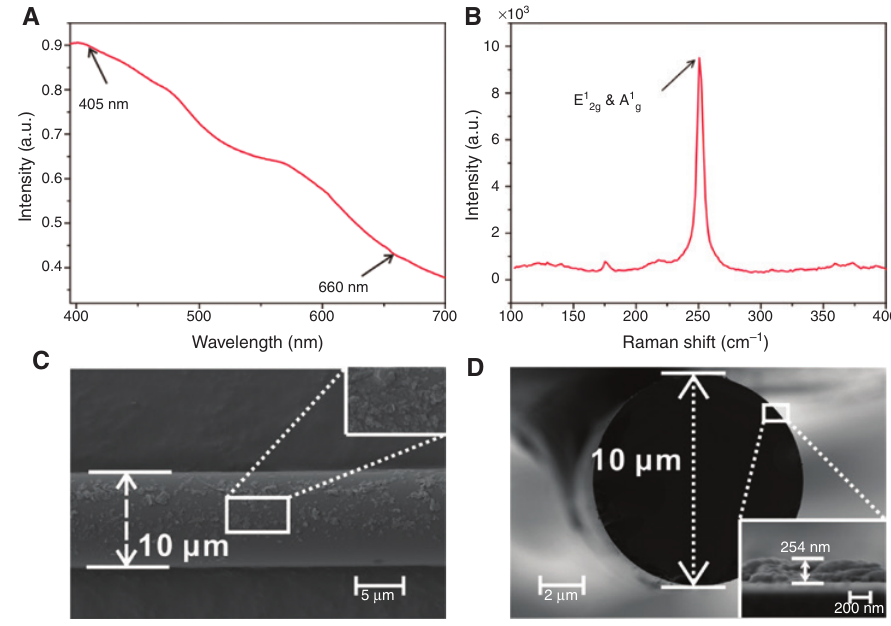
Figure 2: Absorption and Raman spectra, SEM image of the device. (A) Absorption spectrum and (B) Raman spectrum of WSe showing the enlarged view of local position. (D) Profile SEM image of the MF with WSe thickness of ~ 254